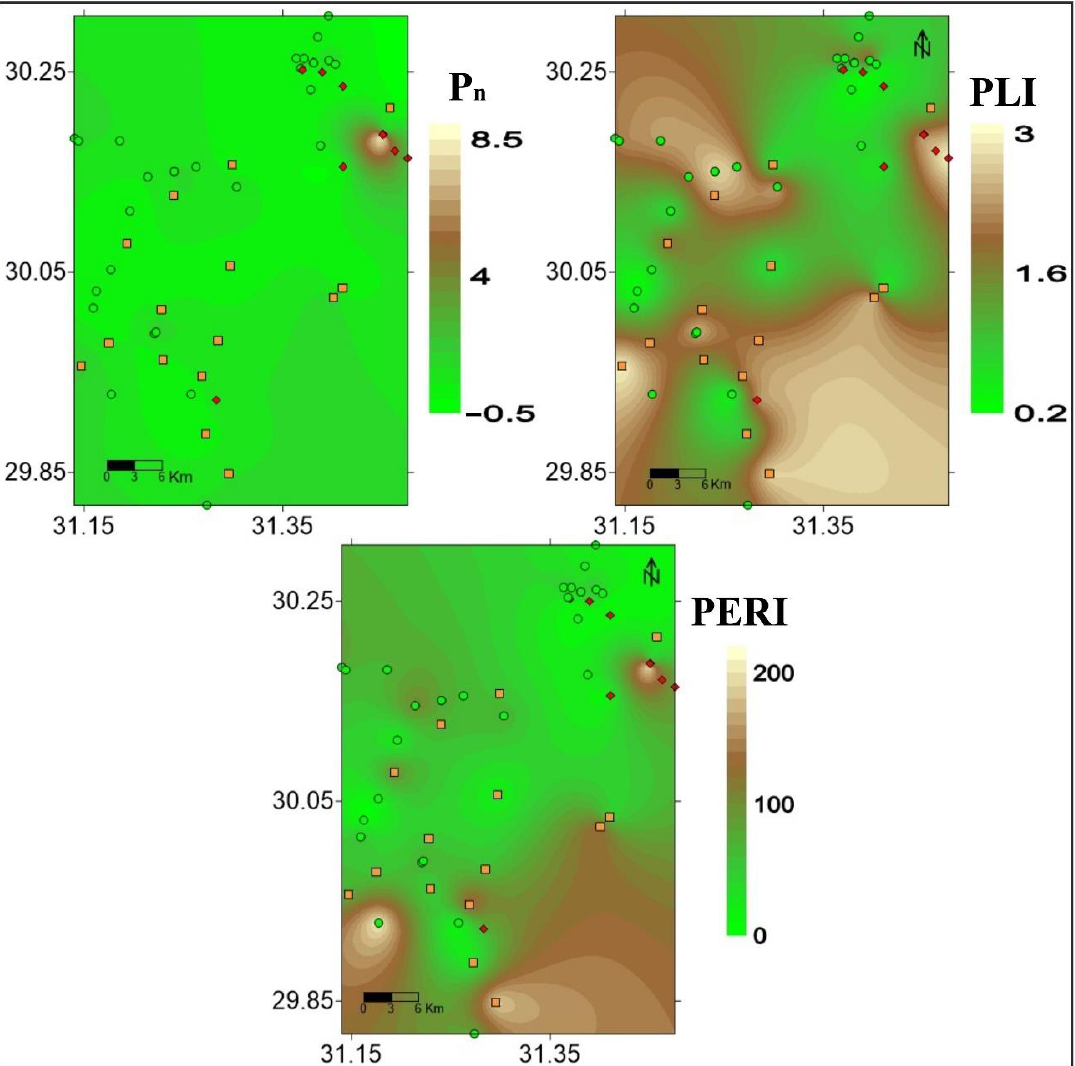
Figure 6. Spatial distribution of P n , PLI, and PERI values.